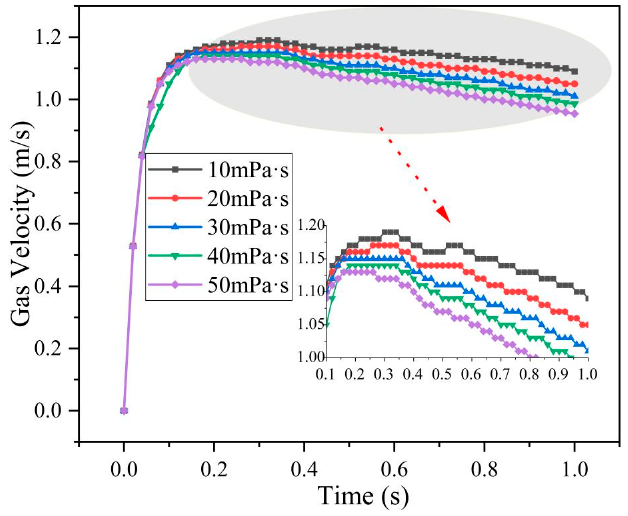
Figure 5. Gas-phase velocity under different drilling fluid viscosities.